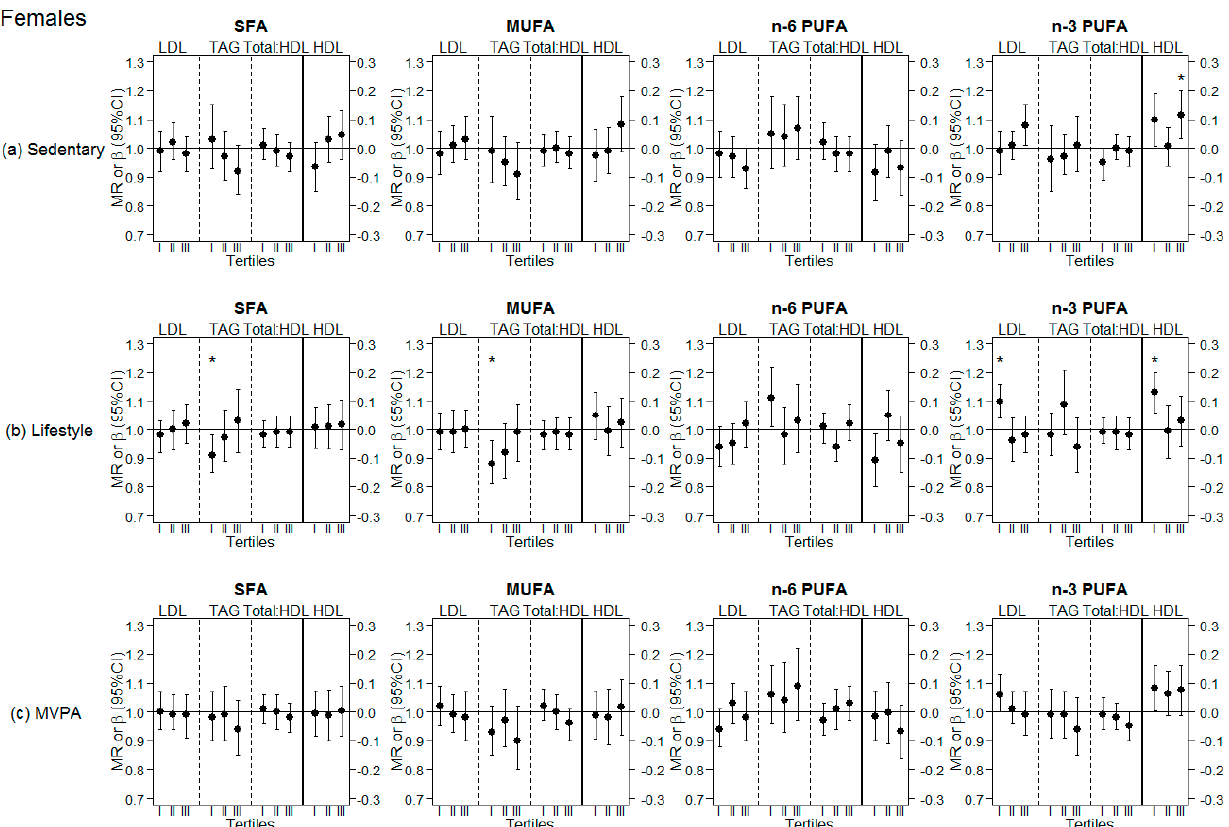
Figure 2. Analyses stratified by tertiles of different physical activity (PA) levels in females. ( a ) Sedentary: Top row, analyses stratified by tertiles of sedentary behavior; ( b ) Lifestyle: Middle row, analyses stratified by tertiles of lifestyle PA; ( c ) MVPA: Bottom row, analyses stratified by tertiles of moderate-to-vigorous PA (MVPA); LDL: Low-density lipoprotein cholesterol; HDL: High-density lipoprotein cholesterol; TAG: Triglycerides; Total:HDL: Total cholesterol to HDL ratio; SFA: Saturated fatty acids; MUFA: Monounsaturated fatty acids; PUFA: Polyunsaturated fatty acids; MR: Means ratio (for effects on LDL, TAG and Total:HDL, on left side of continuous black line); β : Beta coefficient (for effects on HDL, on right side of continuous black line); * significant associations following Bonferroni correction for multiple testing ( p -value < 0.017). Tertiles (I, II, III): Tertiles of the respective physical activity level (Sedentary, Lifestyle PA, MVPA).